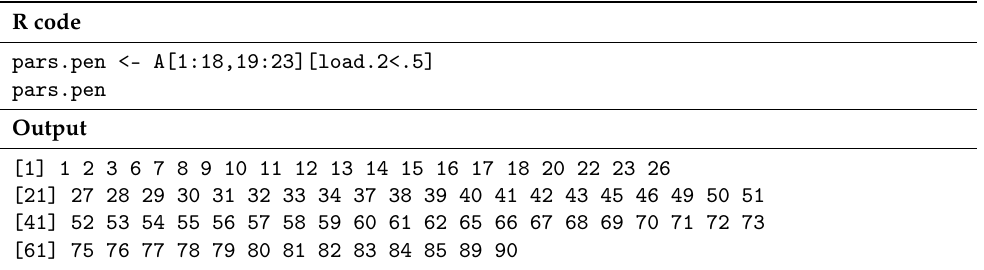
Table 3. Parameter to be